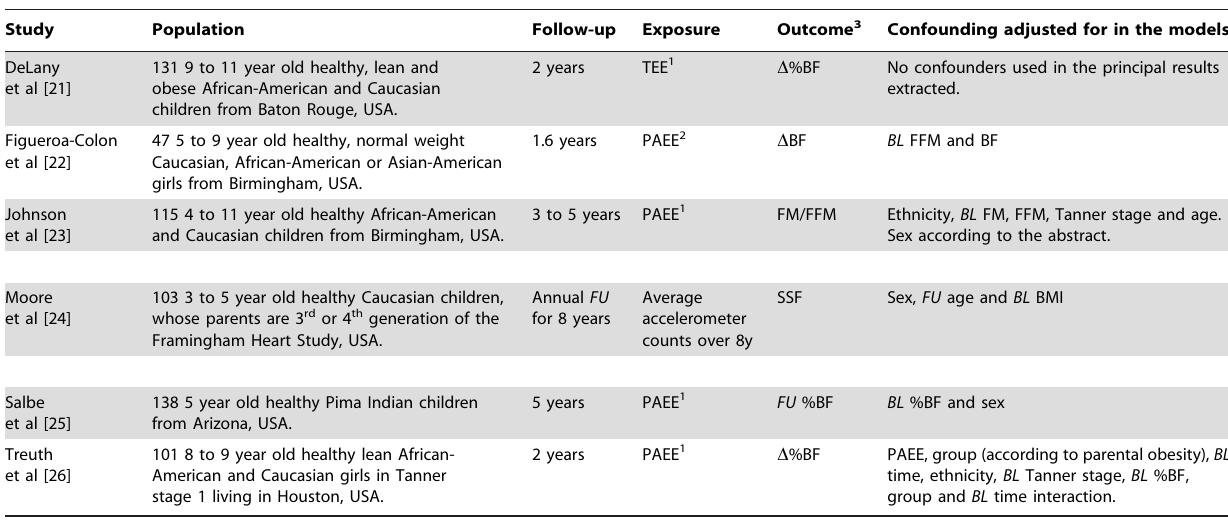
Table 1. Summary of study